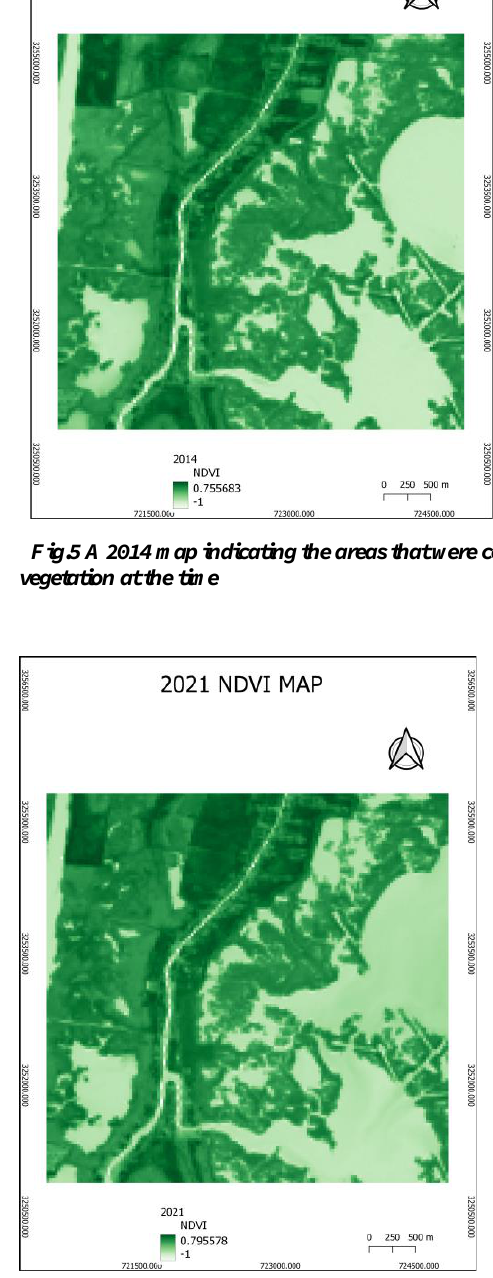
Fig.4 A 2021 map indicating the subtle increase in vegetation